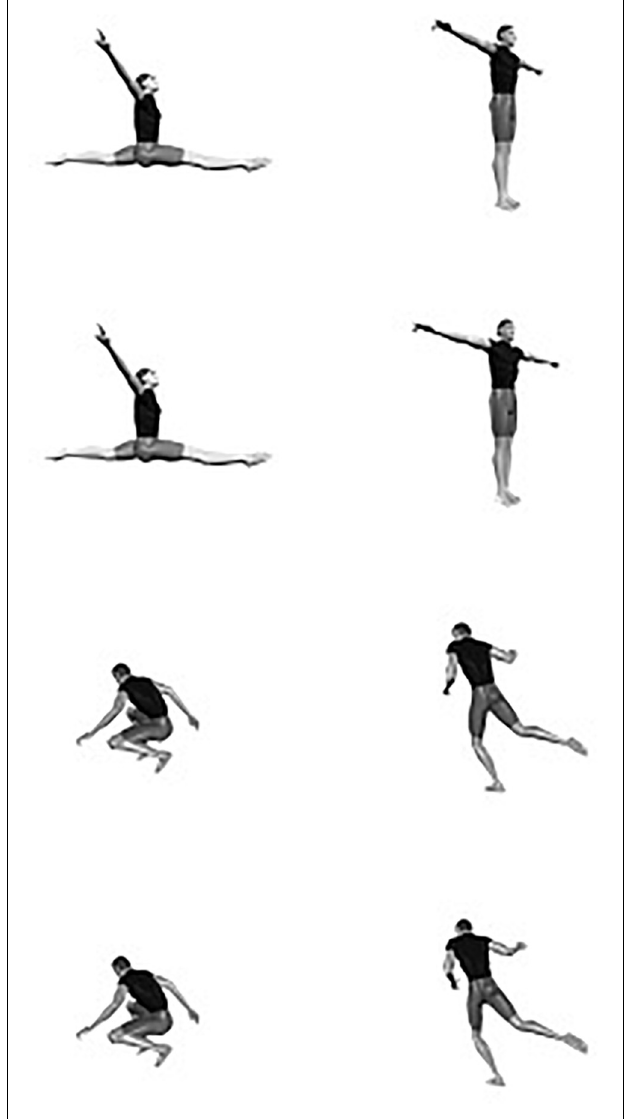
FIGURE 8 | Illustration of the fact that small rotations result in less drastic changes in the projection of the trunk than large rotations (first row: two postures in more or less frontal view (75 and 60 ◦ ) that differ by 15 ◦ in depth; second row: two postures in more or less frontal view (75 and 45 ◦ ) that differ by 30 ◦ in depth; third row: two postures in more or less back view (255 and 240 ◦ ) that differ by 15 ◦ in depth; fourth row: two postures in more or less back view (255 and 225 ◦ ) that differ by 30 ◦ in